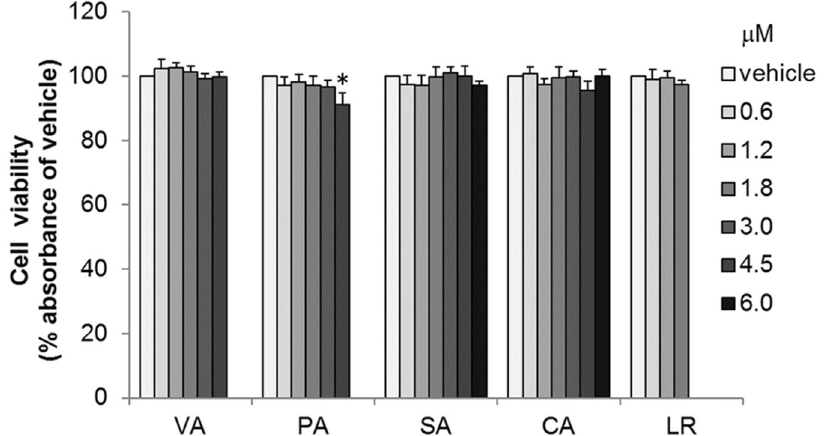
Figure 3. Effect of ume compounds on viability of RBL-2H3 cells. RBL-2H3 cells were treated with SA and CA at concentrations up to 6 mM, VA and PA at concentrations up to 4.5 mM and LR at concentrations up to 1.8 mM. Cell viability is expressed as a percentage relative to the vehicle. Data are expressed as the mean ± SD of triplicate wells (n = 3). * p < 0.05, compared with vehicle.